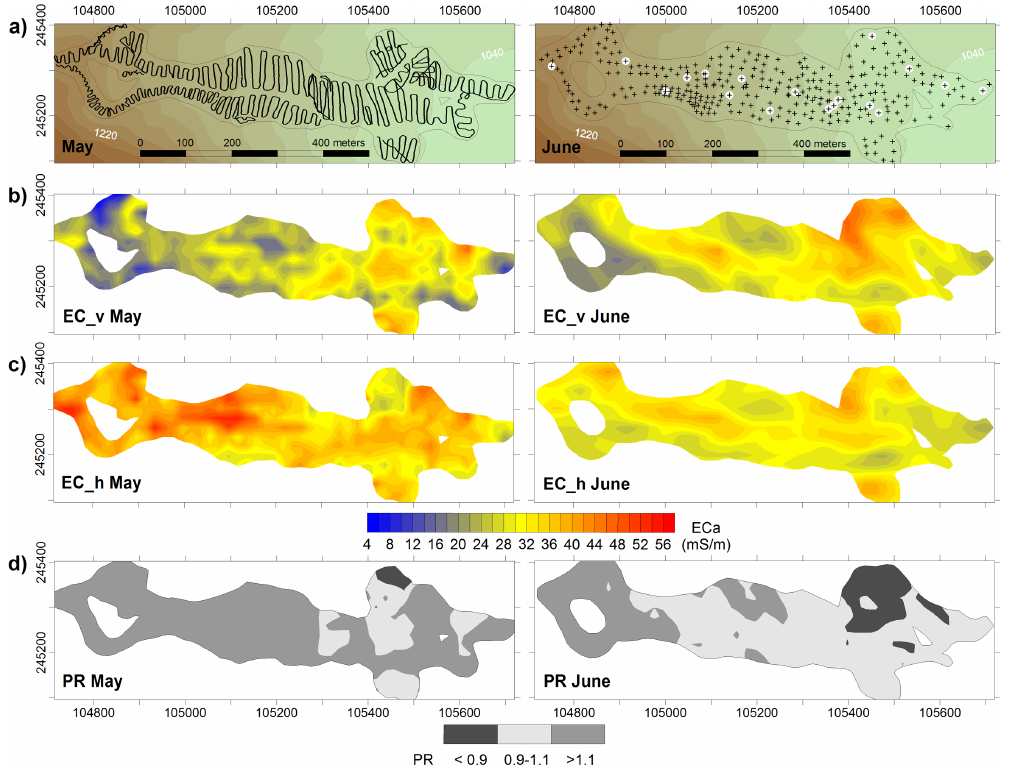
Fig. 2. EMI measurements from May (left column) and June (right column) with different survey designs and location of reading points (a) . White dots in the map on the right show soil sampling locations. The detail views show maps obtained by block ordinary kriging of ECa (mSm − 1 ) using (b) the vertical (EC v) and (c) the horizontal dipole orientation (EC h), as well as (d) the profile ratio (PR). Coordinates on x- and y-axis are in metric BMN M28 Austrian coordinate